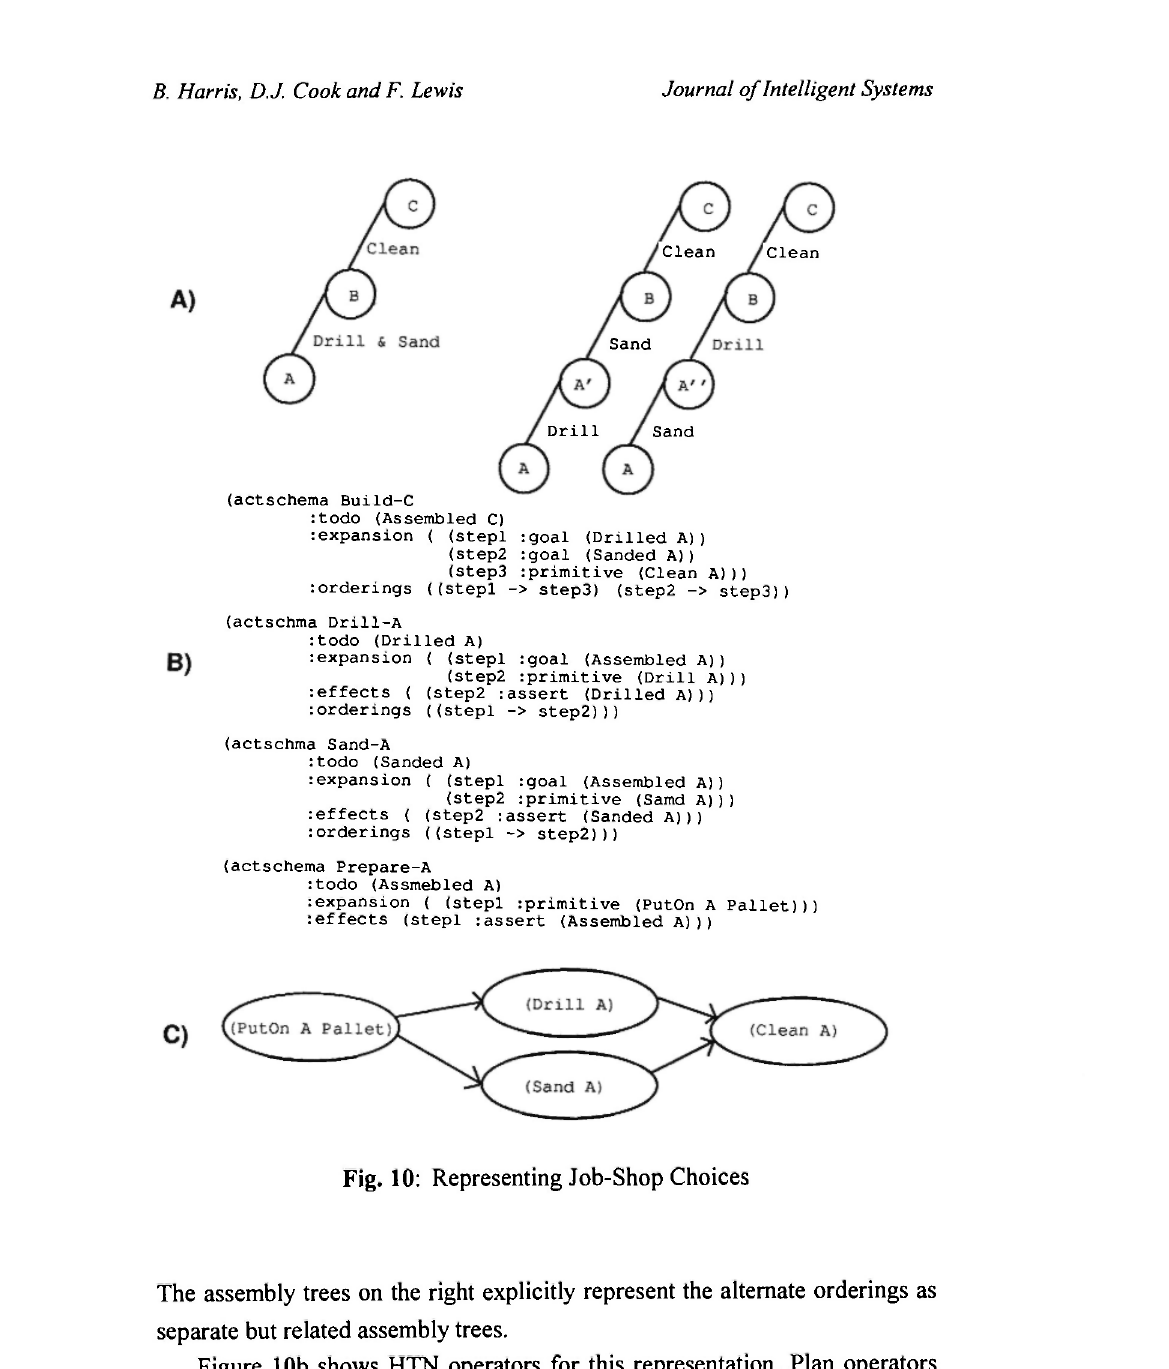
The assembly trees on the right explicitly represent the alternate orderings as separate but related assembly trees.